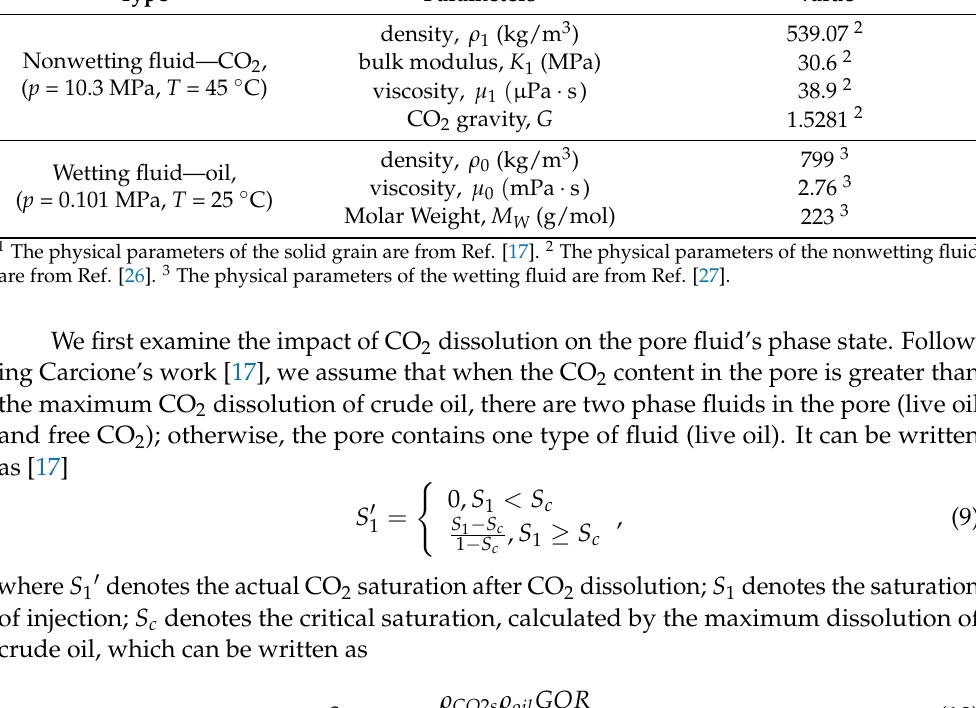
Table 1. Cont. Type Parameters Value Nonwetting fluid—CO 2